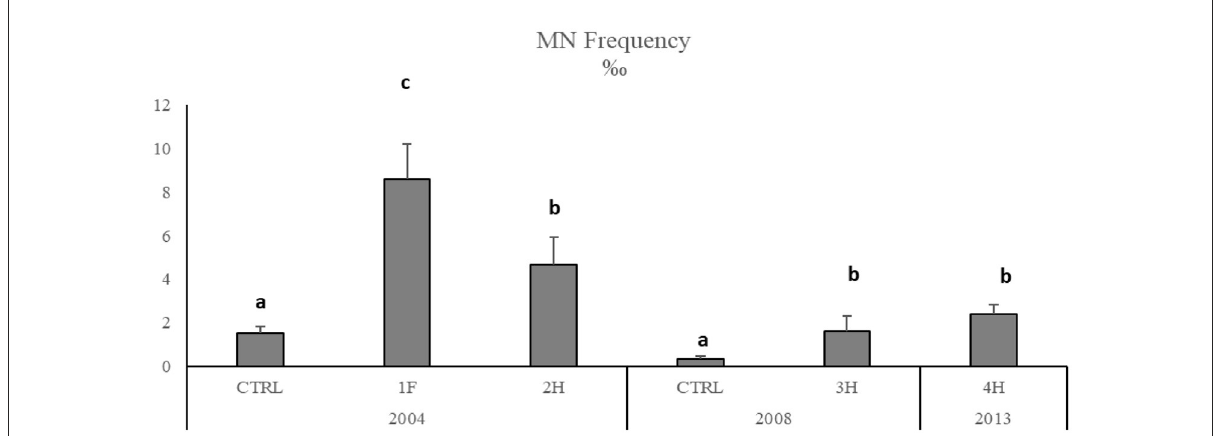
FIGURE4 Micronuclei frequency in M. barbatus gills. Data were expressed as mean ± SEM and n = 5. Letters indicate differences among all the sampling sites, p < 0.01.